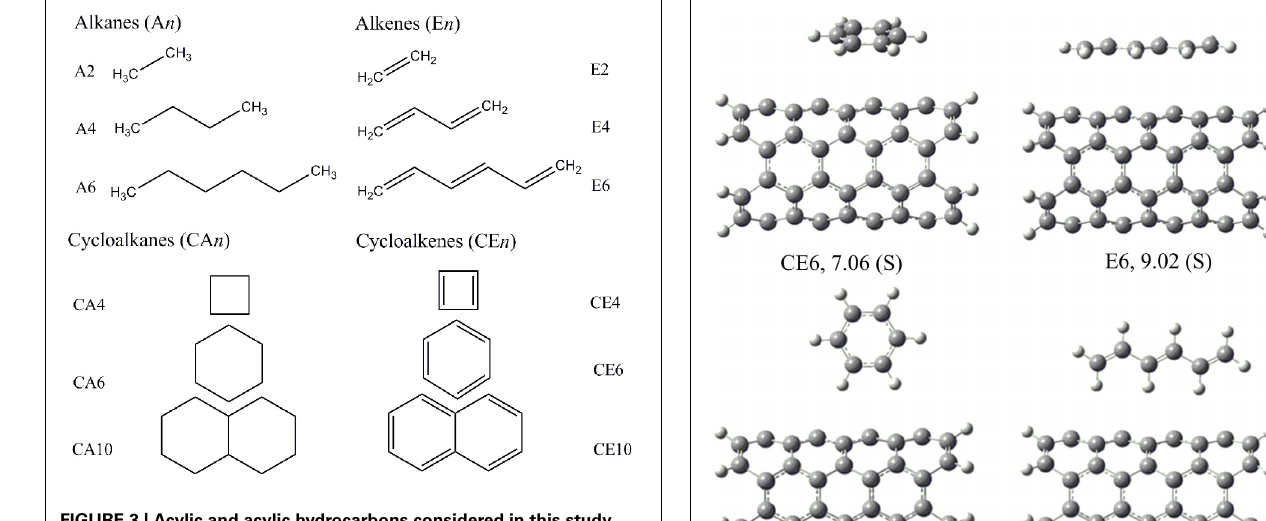
CNTs, zigzag CNTs and GNRs and the values are listed in Table 2